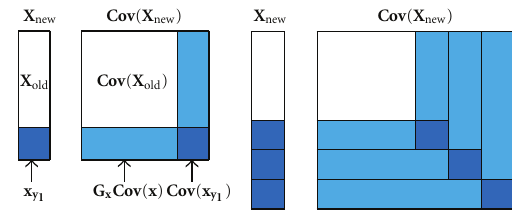
Figure 11: The size of the posterior estimate error covariance ) increases with the number of the targets. The size of the Cov ( X k system covariance is modified from a 13 × 13 matrix to a 19 × 19 matrix while the robot senses one target in the process state